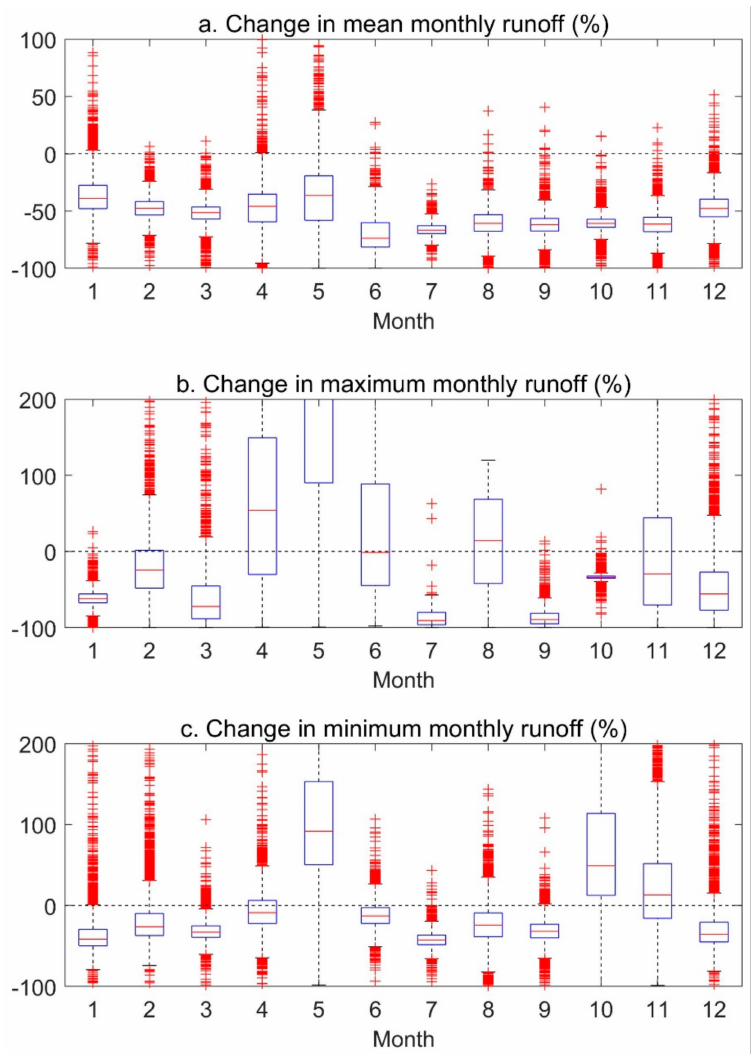
Figure 7. Posterior distributions of percent change in mean ( a ), maximum ( b ), and minimum ( c ) monthly runoff (in y -axis, %) from the baseline to the future period. The vertical spread of the box–whisker plots shows the variations in runoff change randomly generated by the Markov Chain Monte Carlo method. The boxes cover the ranges from the 25% quartile to the 75% quartile of the distributions, with the median values marked by red lines within each box and outliers marked by plus